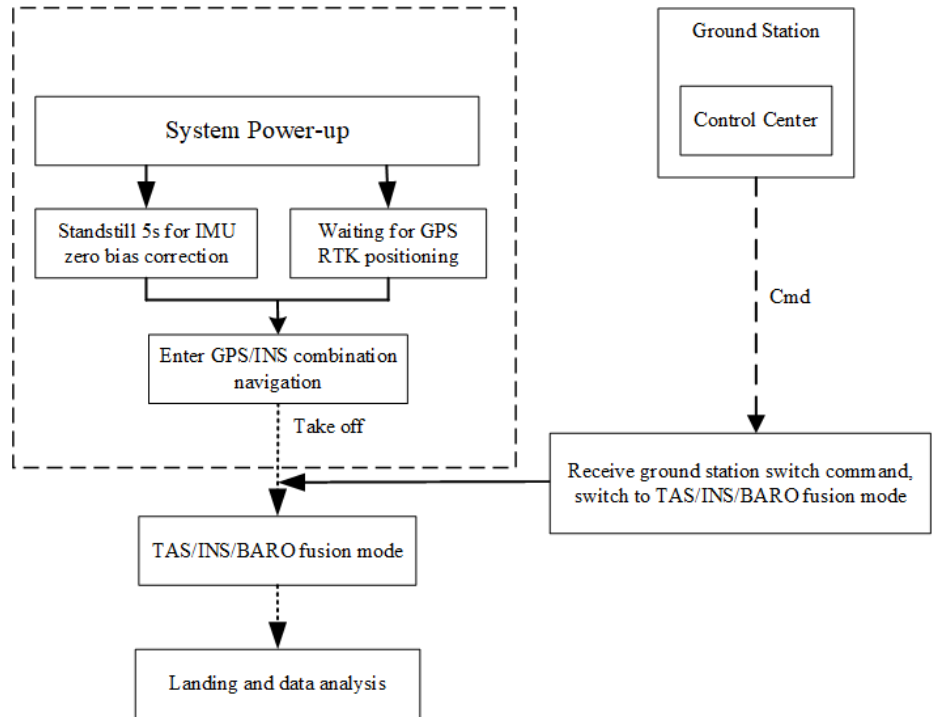
Figure 5. The system experimental task flow chart. The flight control system needs to wait for 5 s